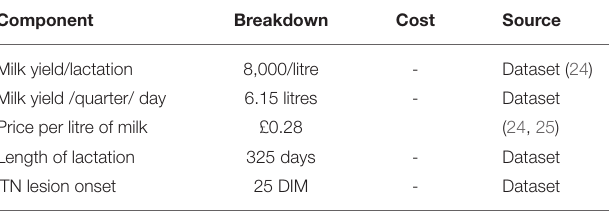
TABLE 4D | The estimated cost for a case of ischaemic teat necrosis (ITN) that required culling before the end of lactation.